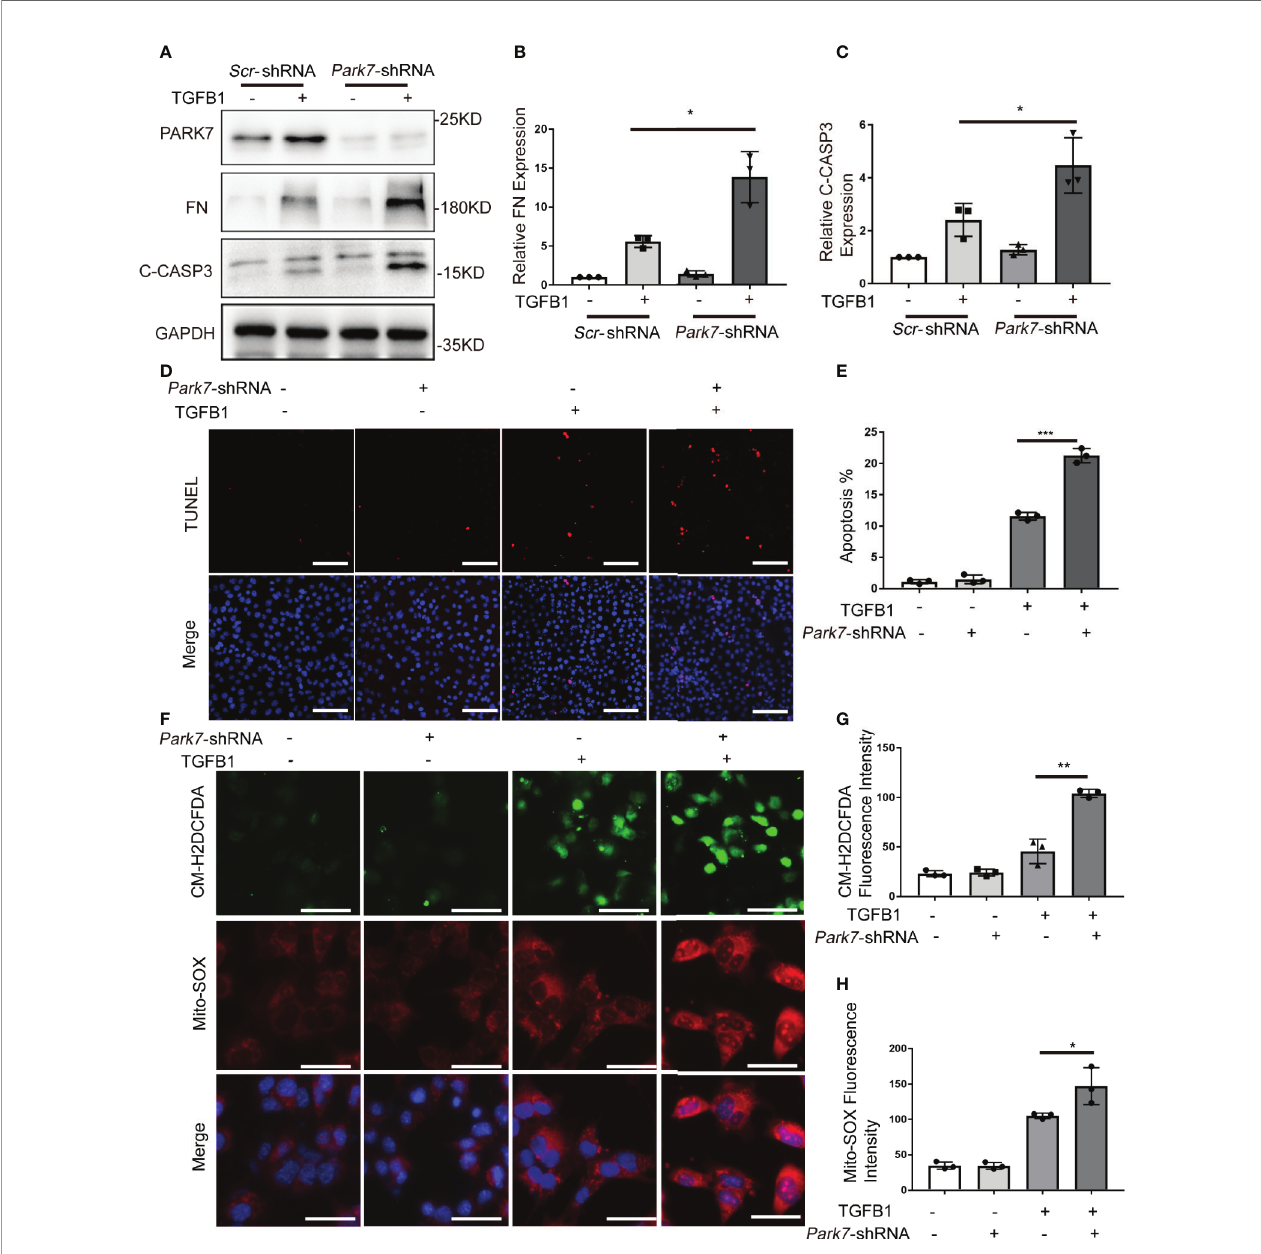
FIGURE 6 | Park7 knockdown sensitizes BUMPT cells to TGFB1-induced fi brotic changes, apoptosis and ROS production. BUMPT cells were transfected with Park7- shRNA or scrambled-shRNA( Scr -shRNA), and at 24 hours after transfection, the cells were incubated with/without 5 ng/ml TGFB1 for another 24 hours. (A) Representative immunoblot of PARK7, Fibronectin (FN), cleaved/activated caspase 3(C-CASP3) and GAPDH (protein loading control). (B, C) Densitometry of FN and C- CASP3(n=3). The signal of FN, or C-CASP3 was normalized to the GAPDH signal of the same samples to determine the ratios. The values are expressed as fold change over control cells without Park7 shRNA transfection. (D) Representative images of TUNEL assay and DAPI staining (X200). Bar:100 m m. (E) Apoptosis percentage(n=3). (F) Representative images of CM-H2DCFDA and Mito-SOX staining. Bar: 100 m m in the CM-H2DCFDA image, 50 m m in the Mito-SOX and Merge images. CM-H2DCFDA and Mito-SOX staining was performed to evaluate intracellular and mitochondrial ROS, respectively. (G, H) Quanti fi cation of CM-H2DCFDA and Mito-SOX fl uorescence intensity(n=3). Each symbol (circle, diamond and trigon) represents an independent experiment. Error bars: SEM. *p < 0.05, **p < 0.01, ***p <